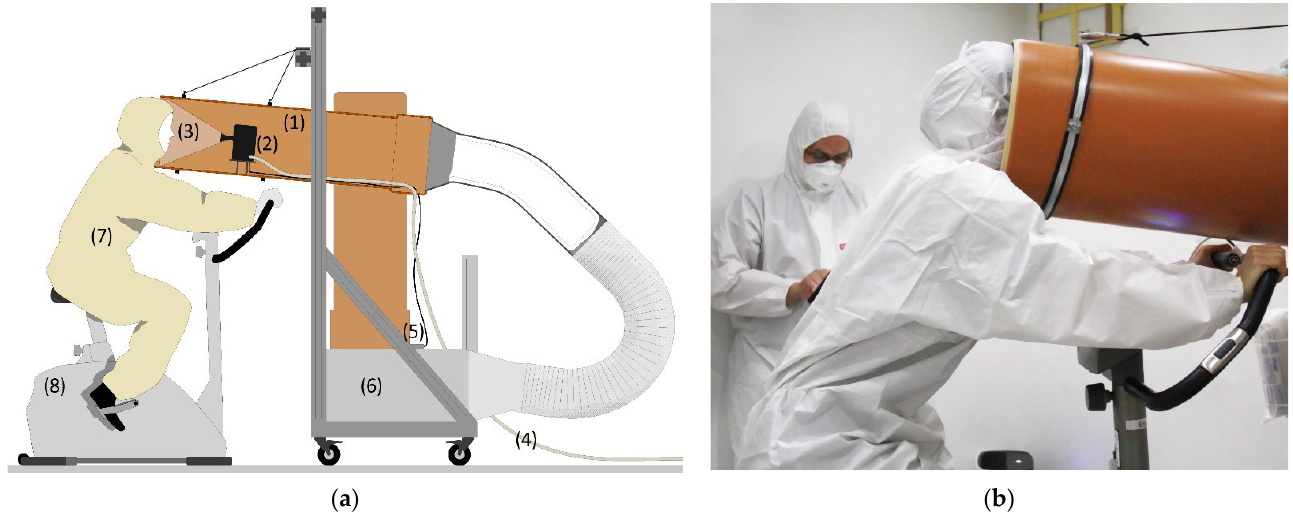
Figure 1. ( a ) The aerosol measurement setup in the lab: (1) PVC pipe, (2) optical particle sensor, (3) collection funnel, (4) plastic tubing to the vacuum pump, (5) data logger, (6) box with a HEPA filter, (7) test subject, and (8) cycle ergometer. ( b ) A test subject while measuring the aerosols emission rate.